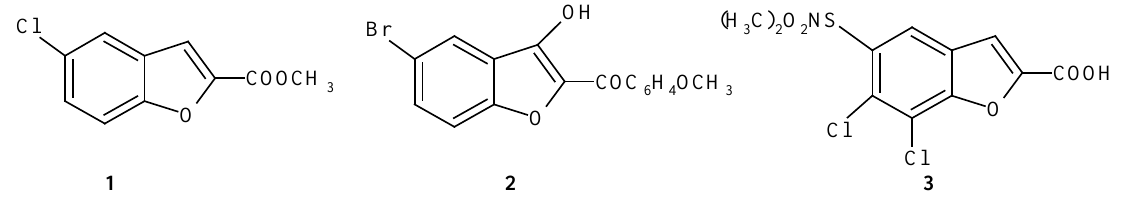
Figure 2. The structures of halo derivatives of benzofurans: methyl 5-chloro-1-benzofuran- 2-carboxylate furan-2-carboxylic acid ( 3